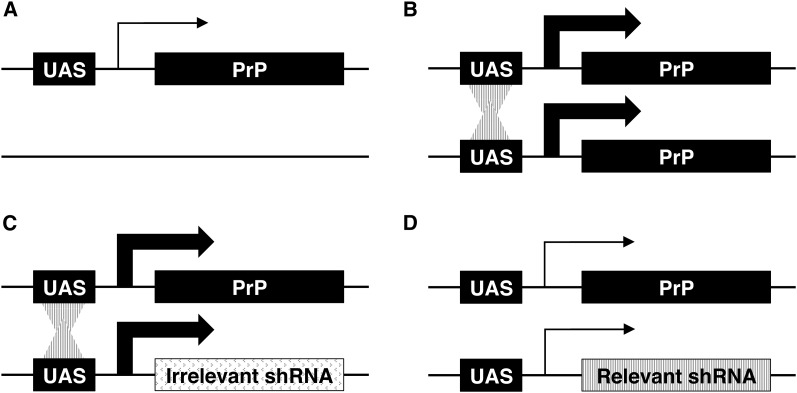
Schematic of an in vivo assay for transvection activity based upon interallelic transcriptional enhancement. All transgenes are inserted at the attP2 locus and the size of the arrow represents the rate of transcription at the associated locus. (A) Hemizygous UAS-PrP is expressed at a low level. (B) Homozygous UAS-PrP is expressed at a high level due to the in trans interaction between UAS enhancers at the same locus. (C) UAS-PrP in combination with UAS-shRNAs targeting genes lacking transvection activity (irrelevant shRNA) also leads to high level PrP expression due to the preserved interaction between UAS enhancers in trans. (D) UAS-PrP in combination with UAS-shRNAs targeting genes with transvection activity (relevant shRNA) interfere with the trans interaction between UAS enhancers, reducing PrP expression. The degree to which target gene knockdown impacts transvection can be simply quantified in this system by a Western blot of PrP levels. PrP, prion protein; shRNA, short hairpin RNA.